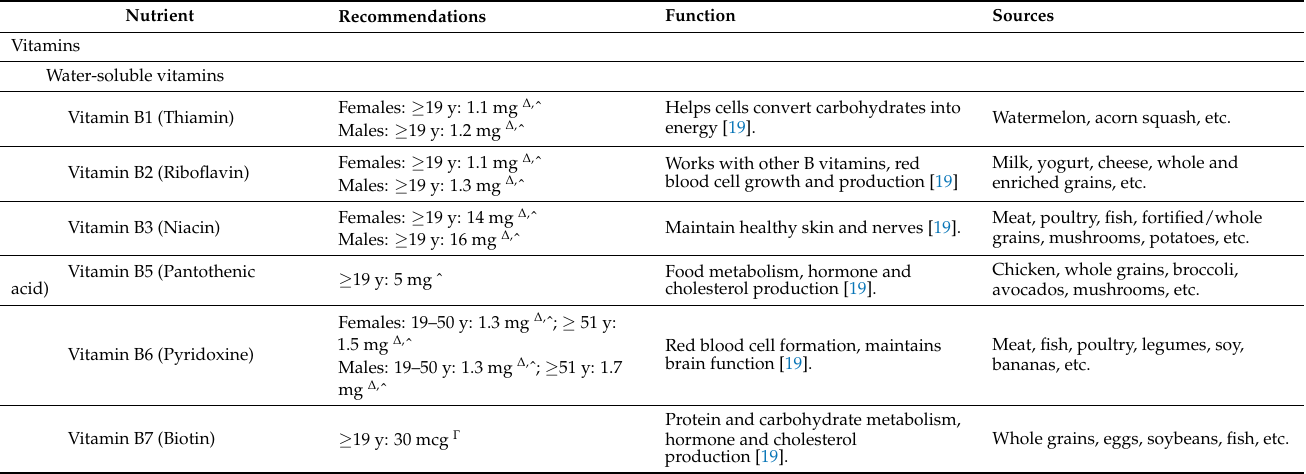
Table 2. Micronutrients (Vitamins and Minerals) Nutrition Education Reference for Health